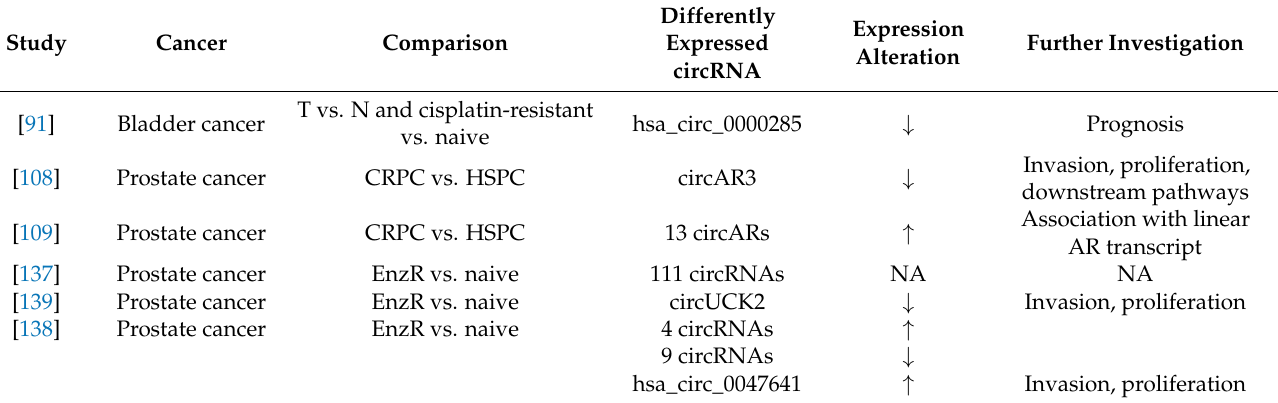
Table 1. Summary of studies that investigated the circRNAs profile after drug